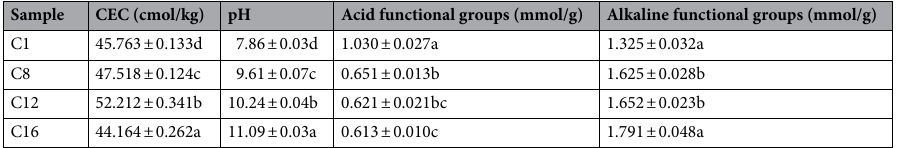
Table 5. Physicochemical properties of biochar at different pyrolysis temperatures. Different letters (a, b, c, d, e) represent significant differences ( p < 0.05) between treatments in same physicochemical properties.